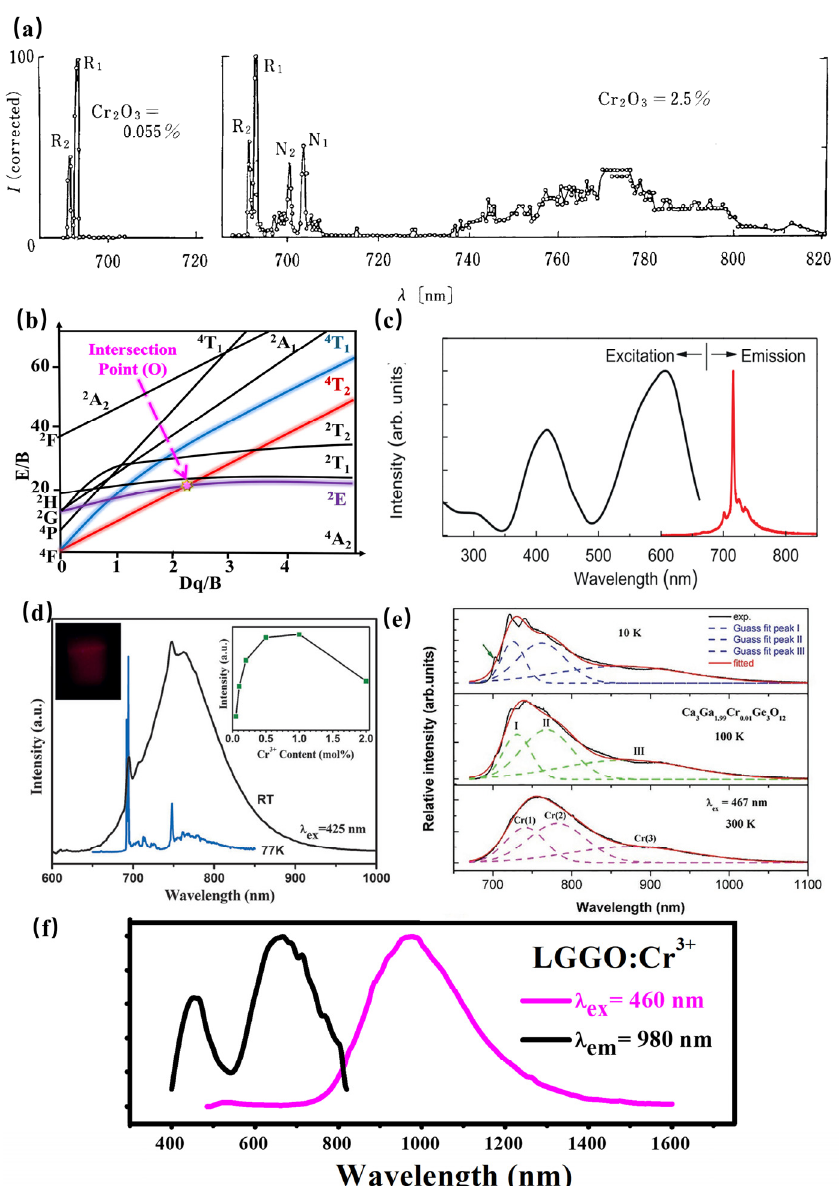
Figure 15. ( a ) PL spectrum of rubies at 77K. ( b ) Tanabe–Sugano diagram of Cr 3+ . ( c ) PL spectra of LiGa 5 O 8 : Cr 3+ (Ex = 400 nm and Em = 716 nm). ( d ) PL spectra of SrGa 12 O 19 : Cr 3+ (Ex = 425 nm and Em = 713 nm). ( e ) PL spectra of Ca 3 Ga 2 Ge 3 O 12 : Cr 3+ (Ex = 267 nm). ( f ) PL spectra of La 3 Ga 5 GeO 14 : Cr 3+ (Ex = 460 nm and Em = 980 nm).